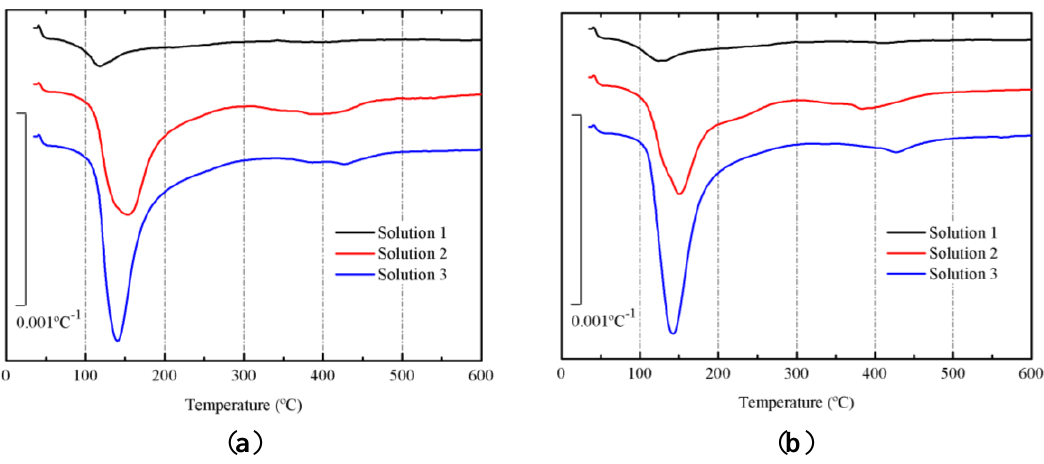
Figure 6. Derivative thermogravimetric curves (DTG) for preliminary study on BFS pastes, after curing at 65 °C: ( a ) 3 days; ( b ) 7